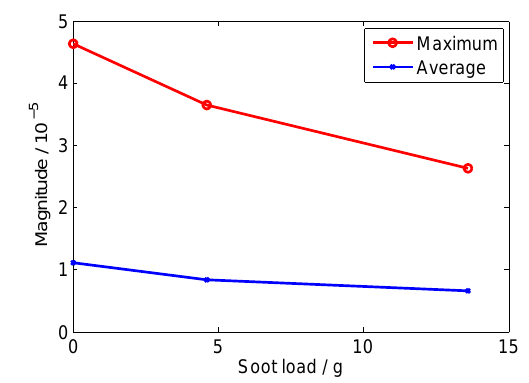
Figure 17. Maximum and average magnitudes of the signal spec- trum at the receiver as functions of the soot load (from Fig.